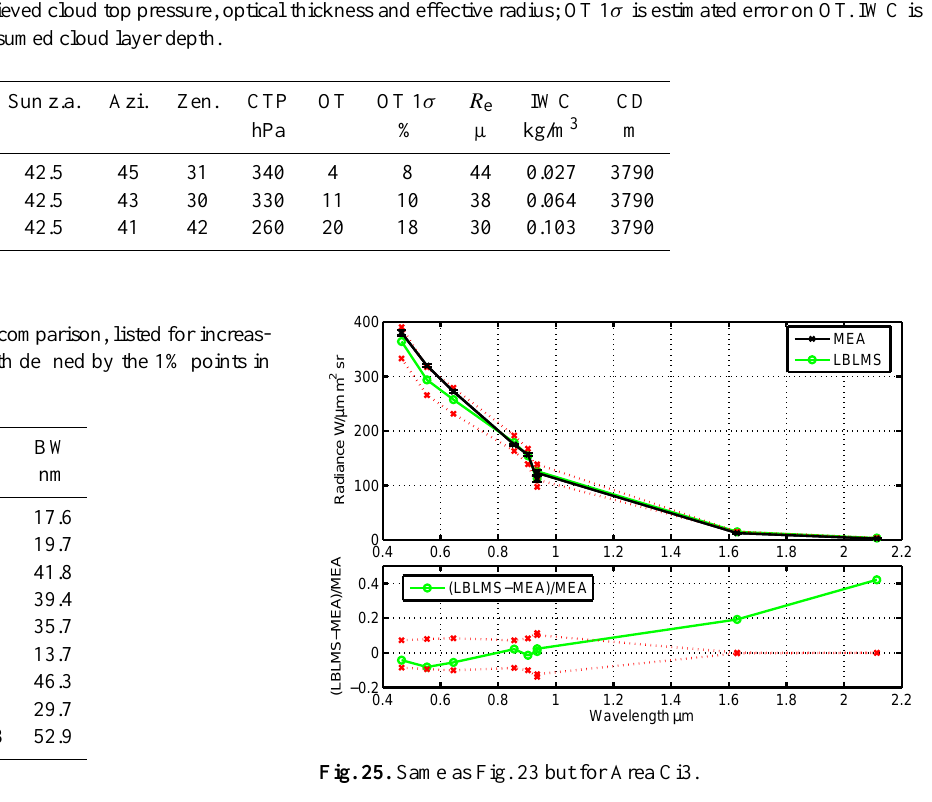
Measurements taken during the 2003 Pacific